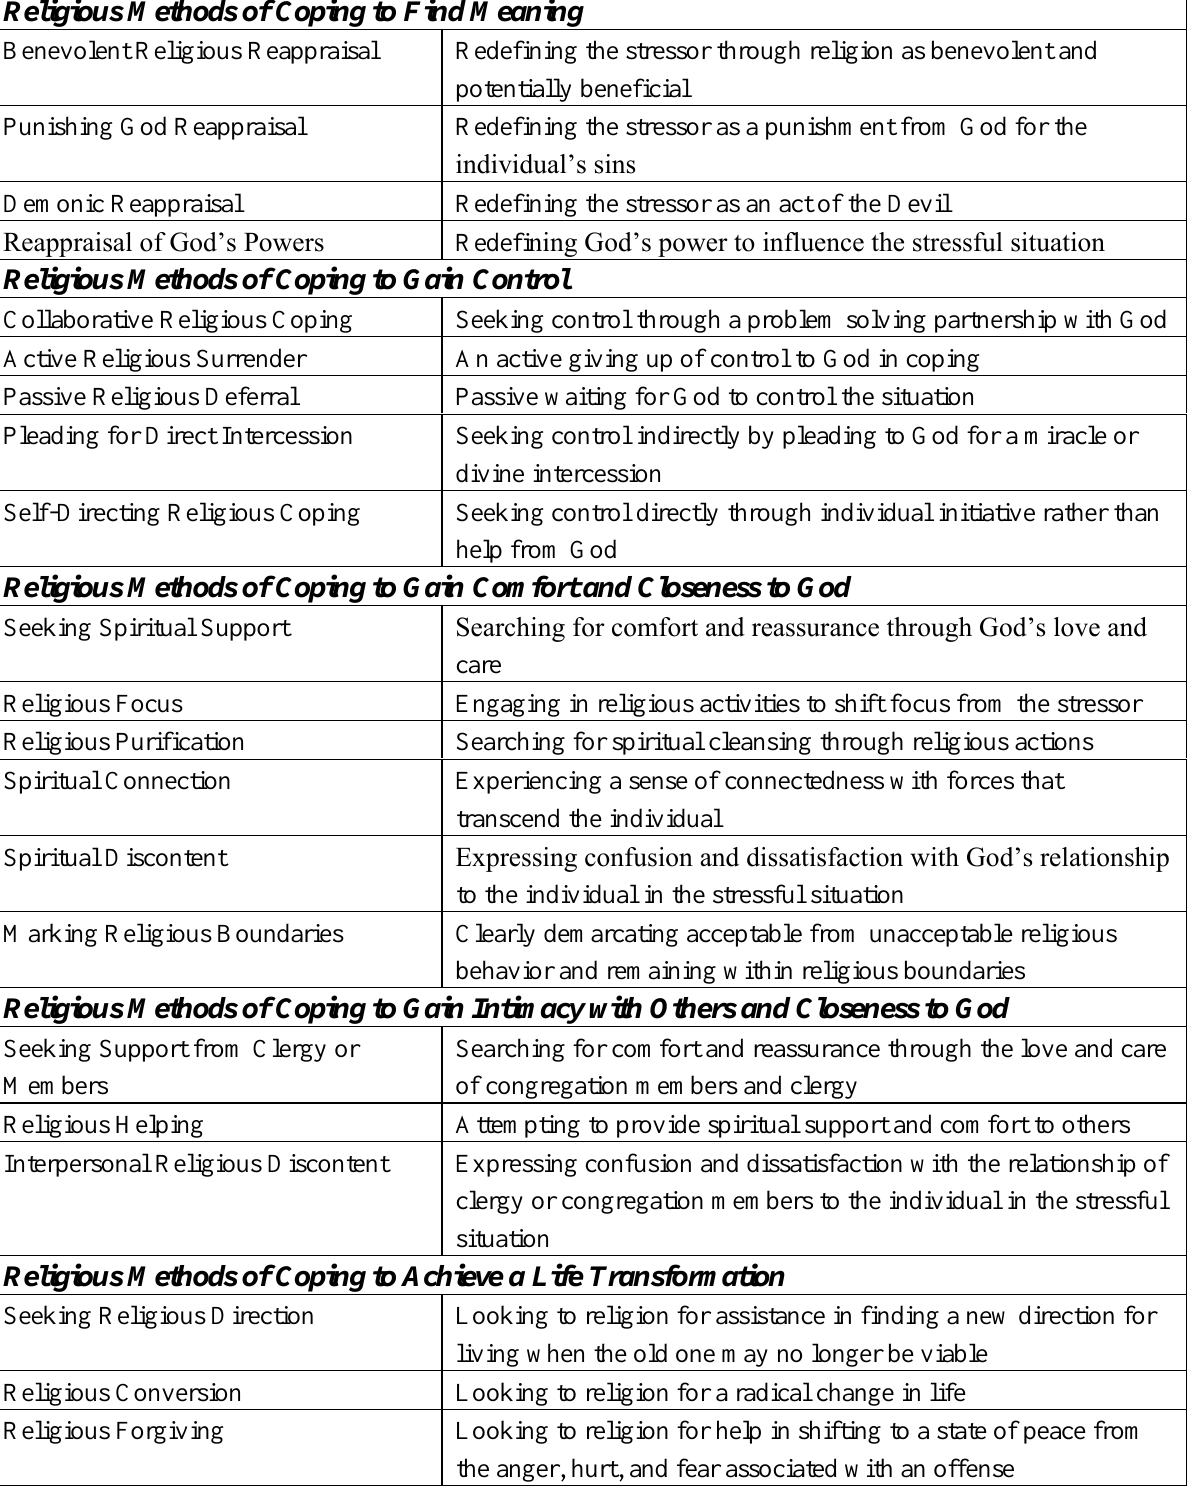
Table 1. RCOPE Subscales and Definitions of Religious Coping